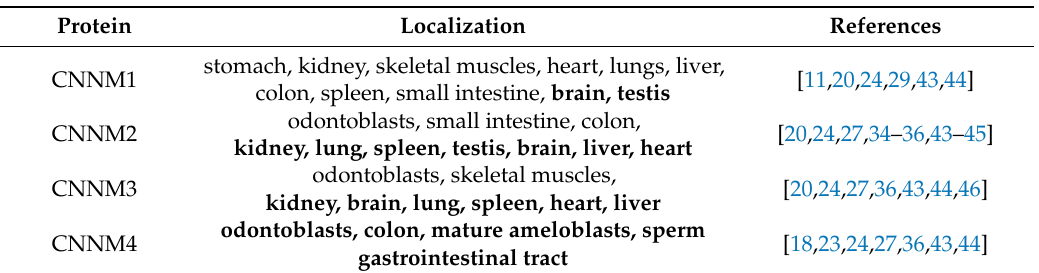
Table 1. Tissue distribution of the CNNM family. High expression levels are marked in bold.